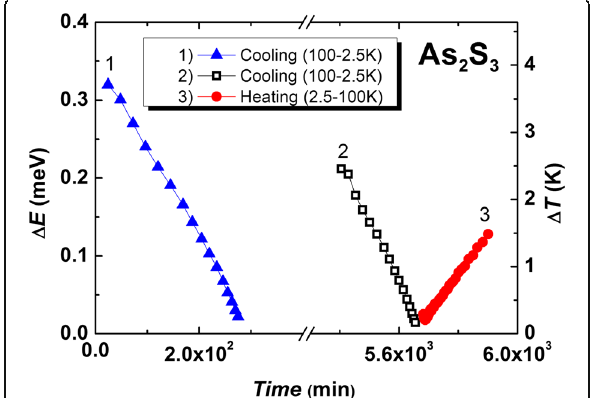
Fig. 2 The time dependence of the temperature difference between the cold and hot ends of the sample in the process of measurement during cooling ( curves 1 , 2 ) and heating ( curve 3 ). ( Color online )